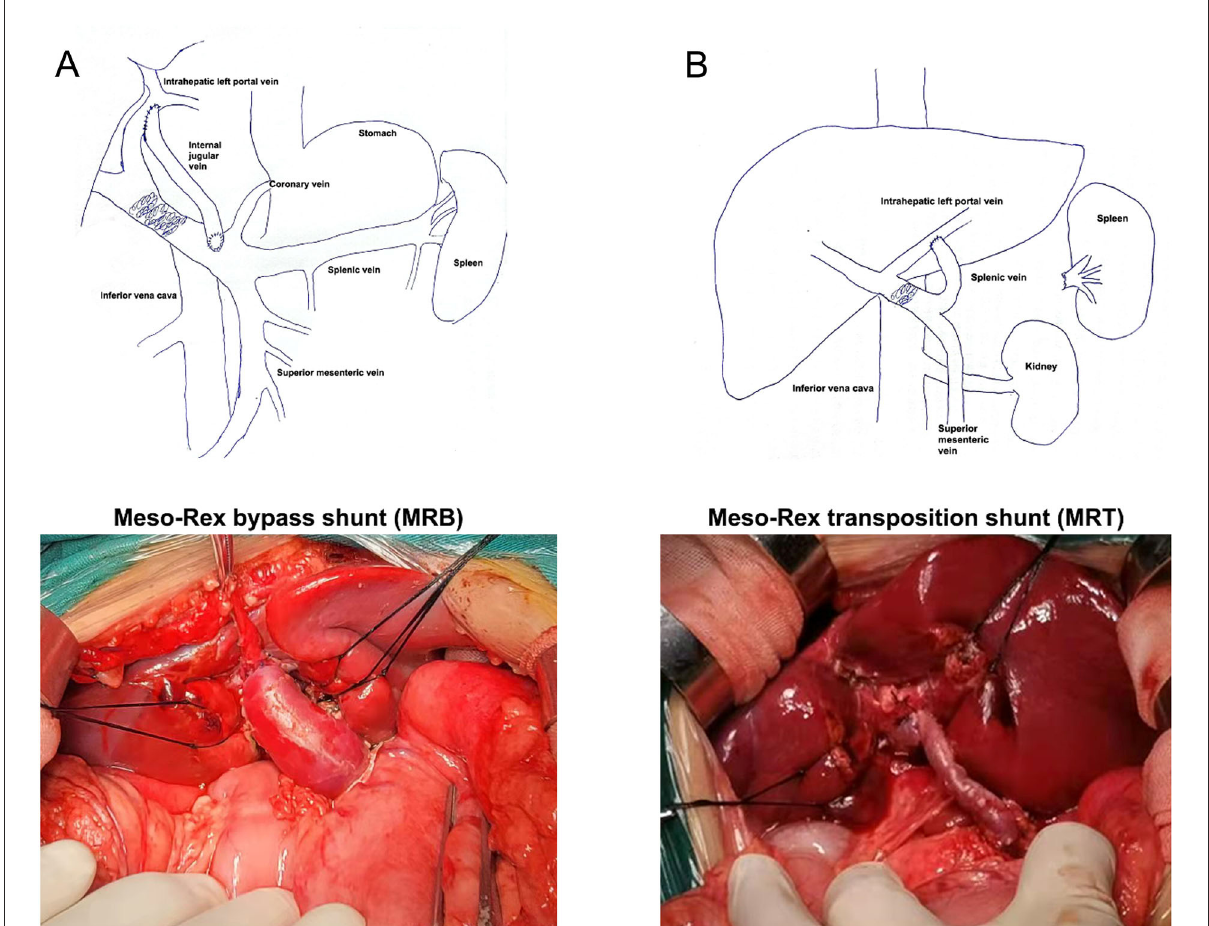
FIGURE1 Schematic illustration of a Meso-Rex shunt. MRB, an internal jugular vein, was interposed between the superior mesenteric vein and the left portal vein within the Rex recessus of the liver.MRT, a dilated and mobilized splenic vein, was directly anastomosed to the left portal vein without the vein graft. (A) Meso-Rex bypass shunt. (B) Meso-Rex transposition